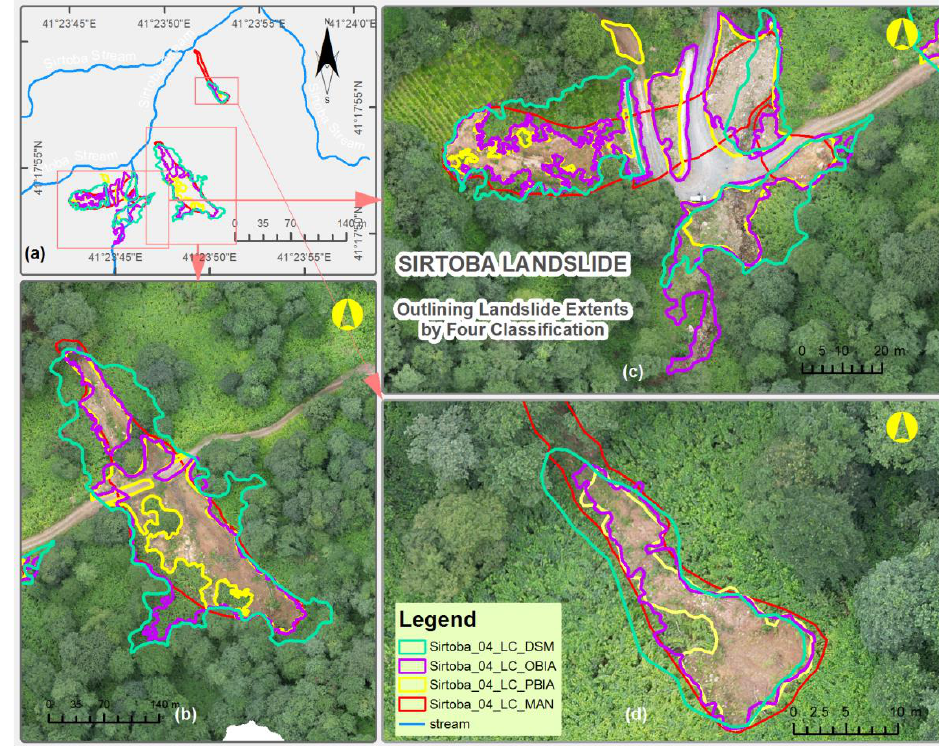
Figure 14. Outlining the extent of landslide boundaries using the four classifications: ( a ) overall extent of four classifications; ( b ) head and toe zones of the landslide with a road passing in the middle; ( c ) an intersectional zone at roads, streams, and landslides between erosion and deposition of the landslide debris; and ( d ) fast-growing plants in the depositional zone of the landslide in the Sirtoba case study site in Turkey. Table 5. The statistics produced by each method for the Turkish